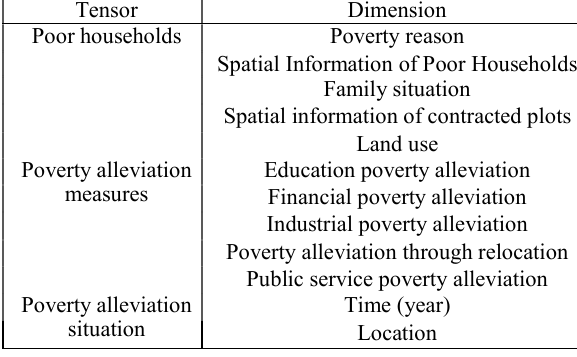
Table 2. Dimensions and ranges of